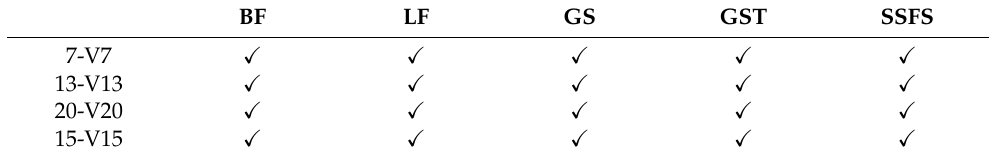
Table 6. Results of feature selection using five wrapper classifiers (symbol